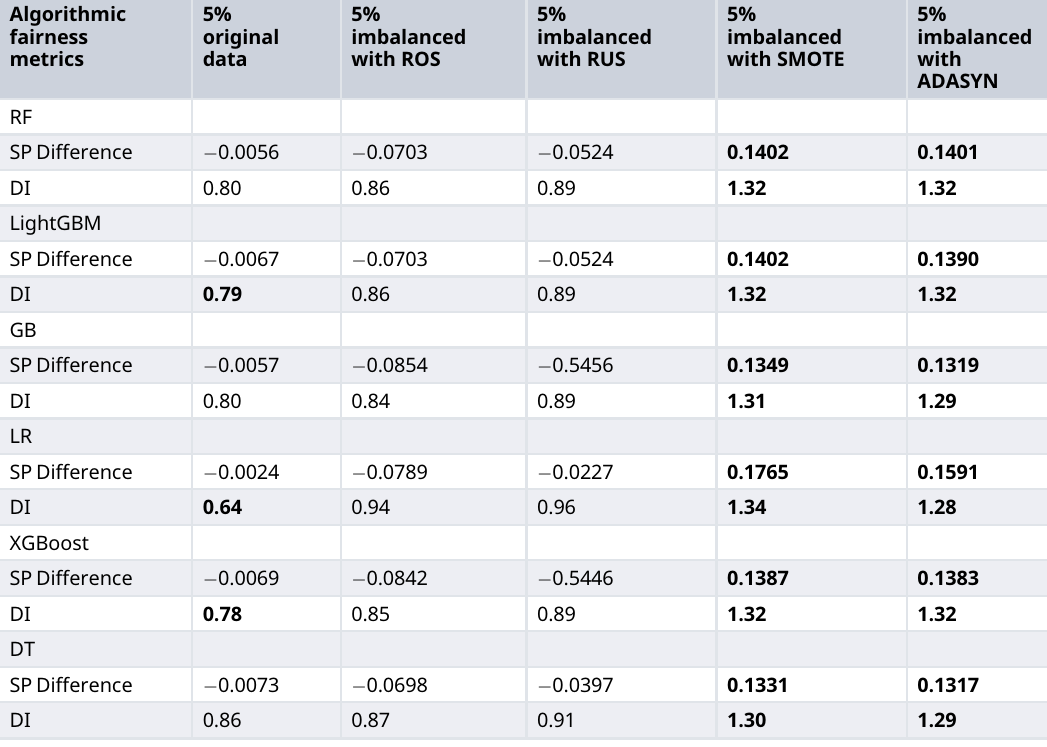
Table 6. The algorithmic fairness measures on 5% unbalanced dataset. Algorithmic fairness